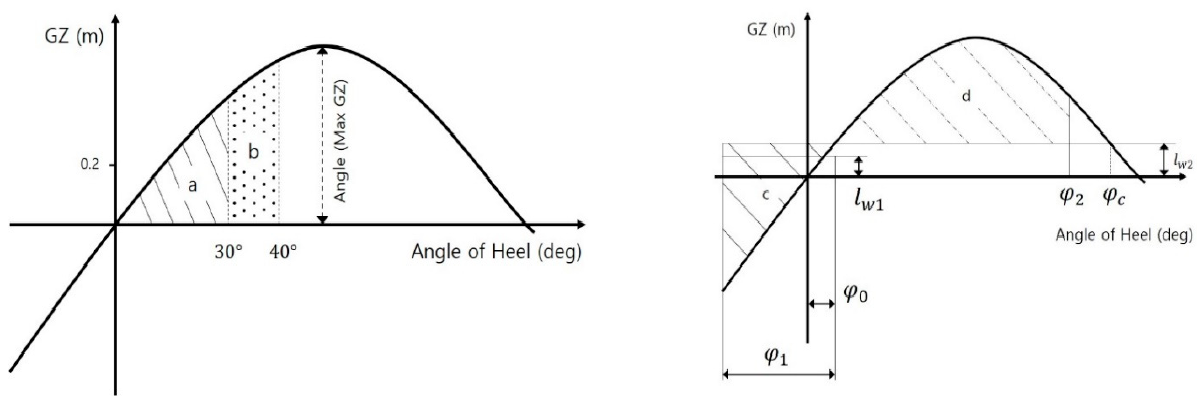
Figure 2. Area under GZ curve ( Left ) and weather criterion ( Right ) [24].